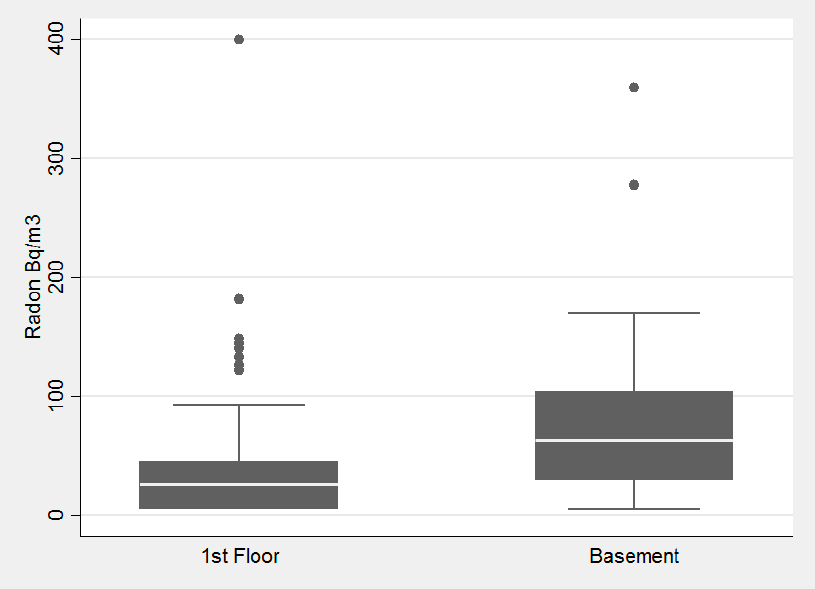
Figure 6. Association with sample location and radon concentration in the pilot study of homes tested in DeKalb County in 2015.